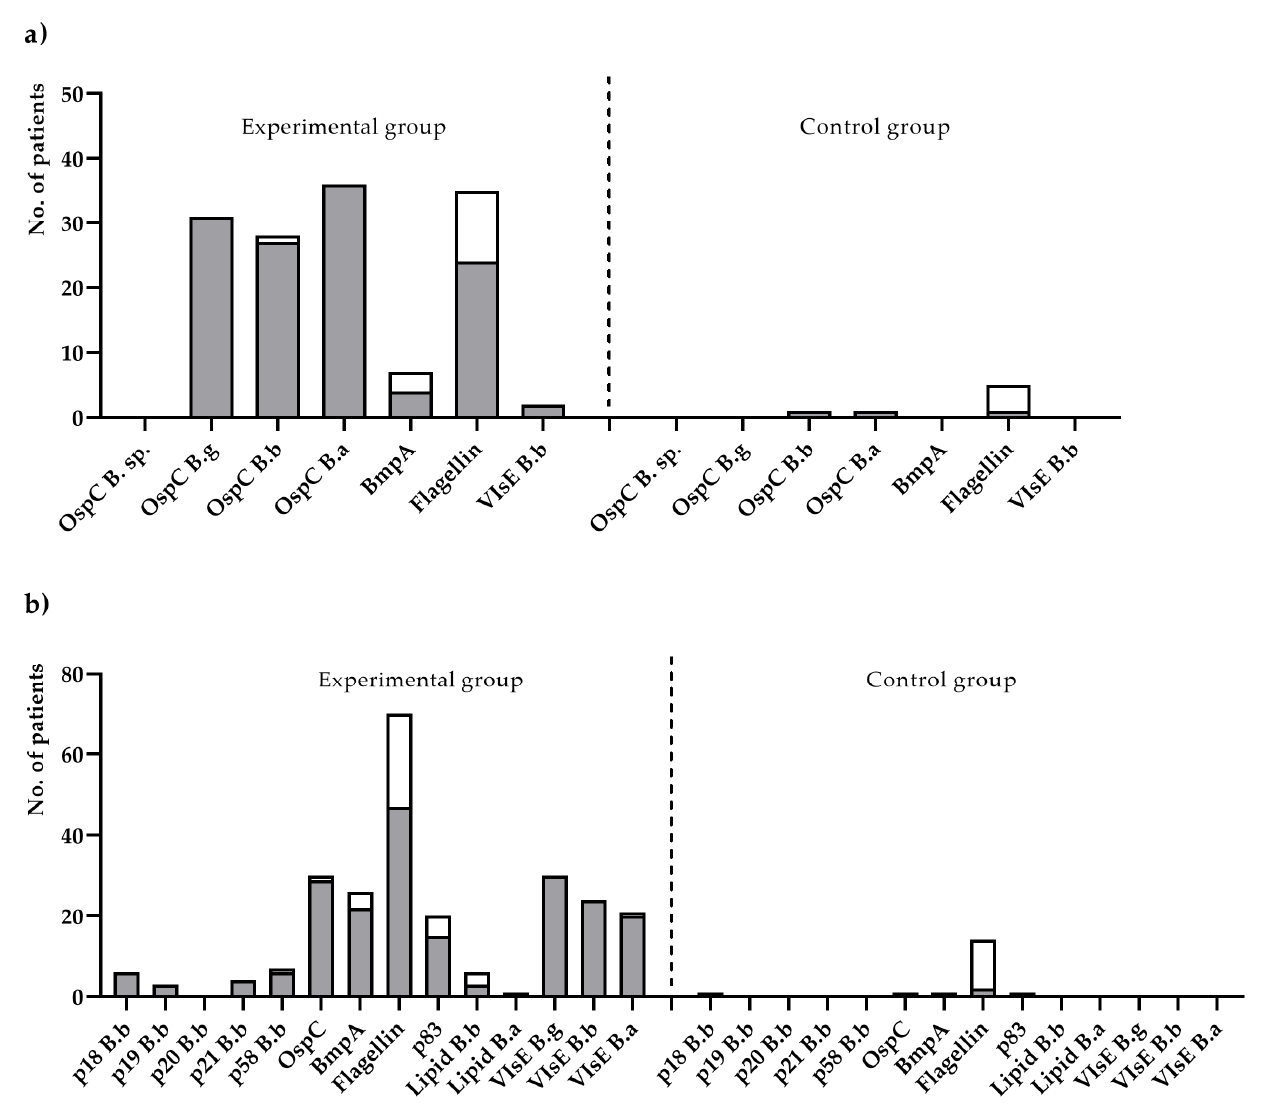
Figure 1. The number of positive results obtained from Lyme disease patients (experimental group) and healthy individuals (control group) for the IgM ( a ) and IgG ( b ) antibody types for particular antigens, included in the immunoblot assay. The white-colored mark is the number of antigens obtained from positive results; the grey-colored mark is the number of antigens obtained from negative results.